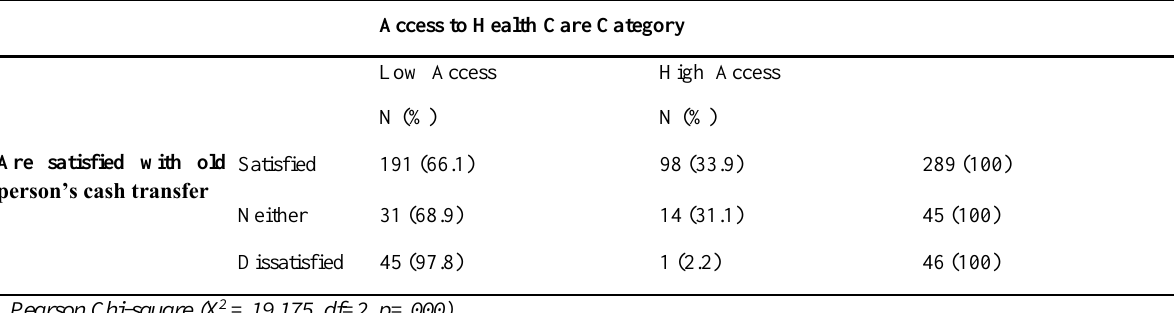
Table 6: Cross-Tabulation of Cash Transfer and Access to Health Care